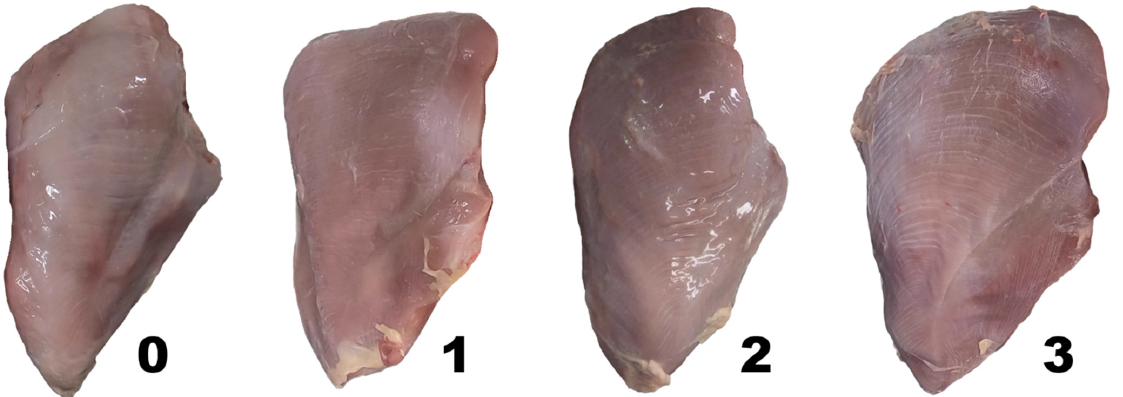
Figure 1. Visual scoring system used for scoring white striping severity of the Pectoralis major (fillet). Where 0 (normal) = no to minimal white striations; 1 (moderate) = thin white striations visible on the breast, most of which tended to occur at the caudal end of the fillet (bottom of pictured fillets); 2 (severe) = large white striations visible on the breast spread between the caudal end and the main body of the fillet (top of pictures fillets); 3 (extreme) = thick white striations visible on the breast covering majority of the outer surface. Pictures by Ryley J. Vanderhout.